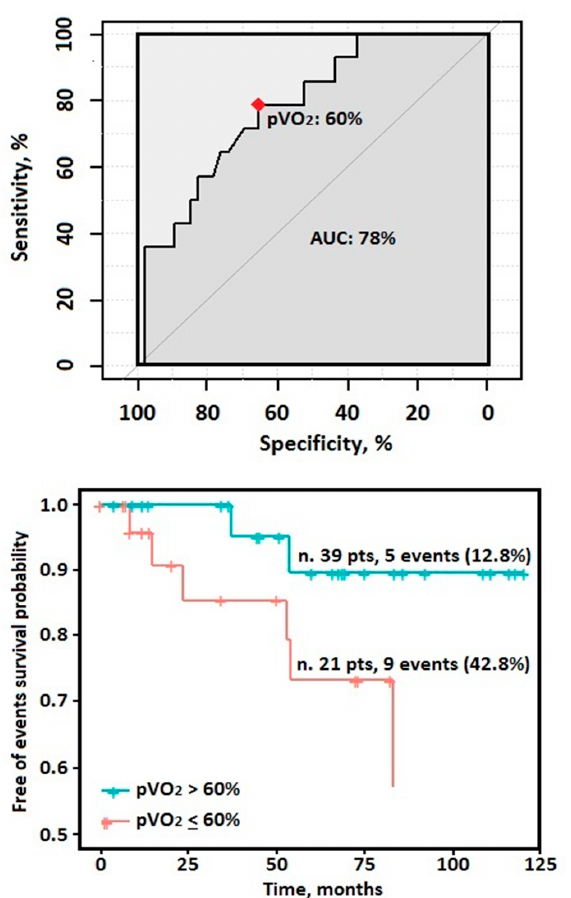
Figure 3. (Upper) Receiver-operating characteristic (ROC) analysis showing the point with the best accuracy of the peak oxygen uptake (pVO 2 ) in the HCM study sample ( n = 60). (Lower) Kaplan– Meier estimator of cardiovascular events for the pVO 2 according to a 60% cutoff